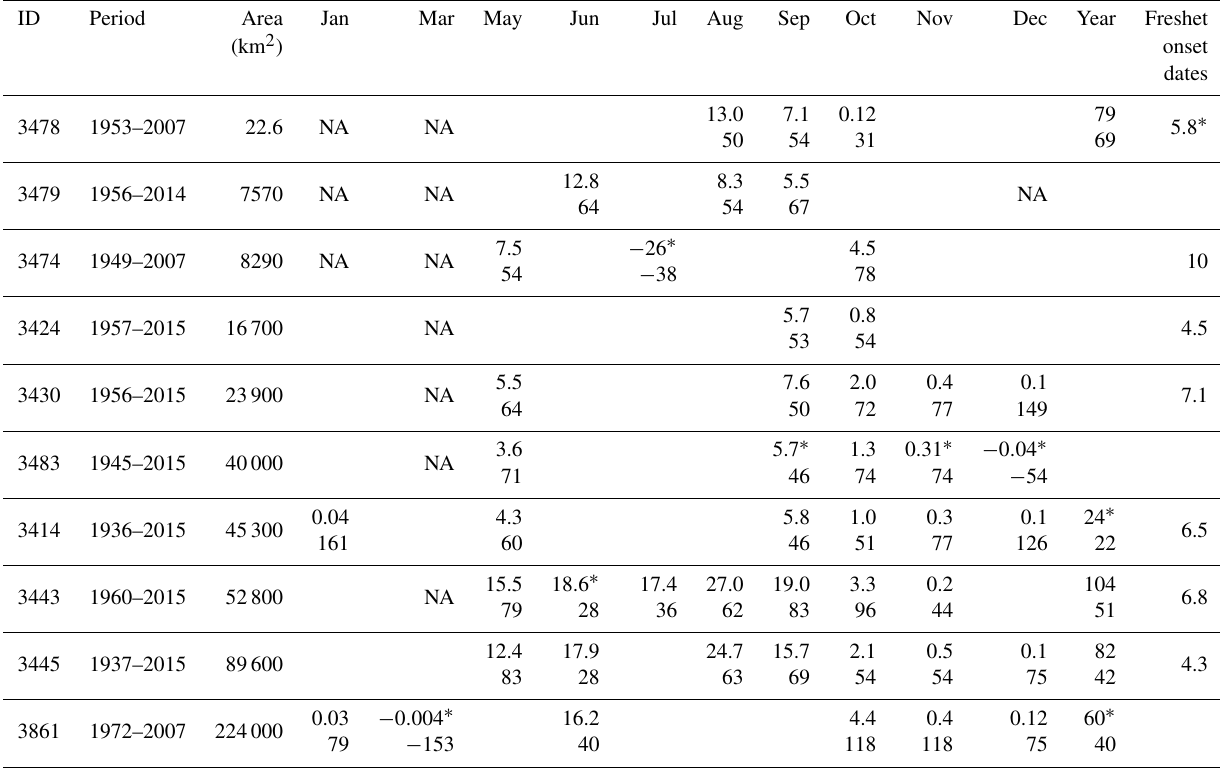
Table 7. Changes in monthly and annual streamflow (millimeters and percent) and freshet onset dates. The Yana River basin. ID